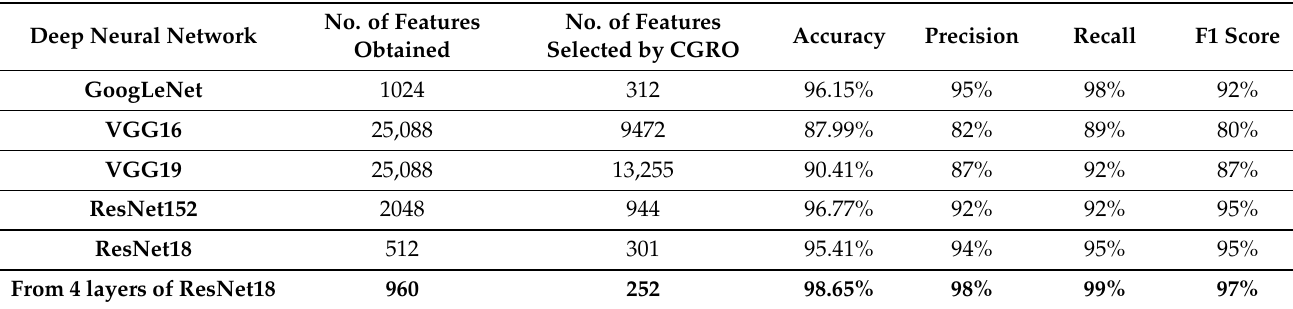
Table 3. Results obtained on SARS-Cov-2 CT-scan dataset using different models. Different parameters and obtained results with 4 layers features of ResNet18 are highlighted boldly in the table.